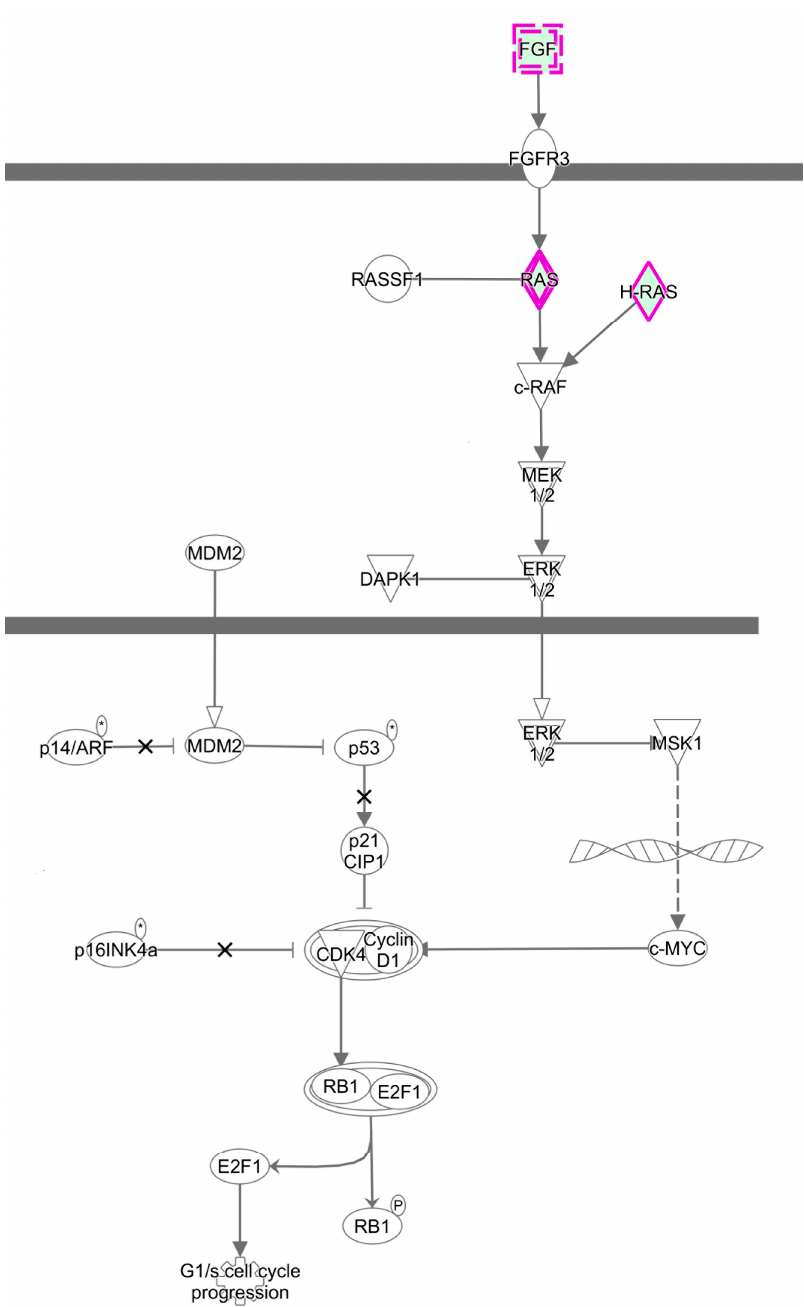
Figure 7. The RAS-RAF-MEK-ERK pathway was predicted to be targeted by differentially expressed miRNA ( p <